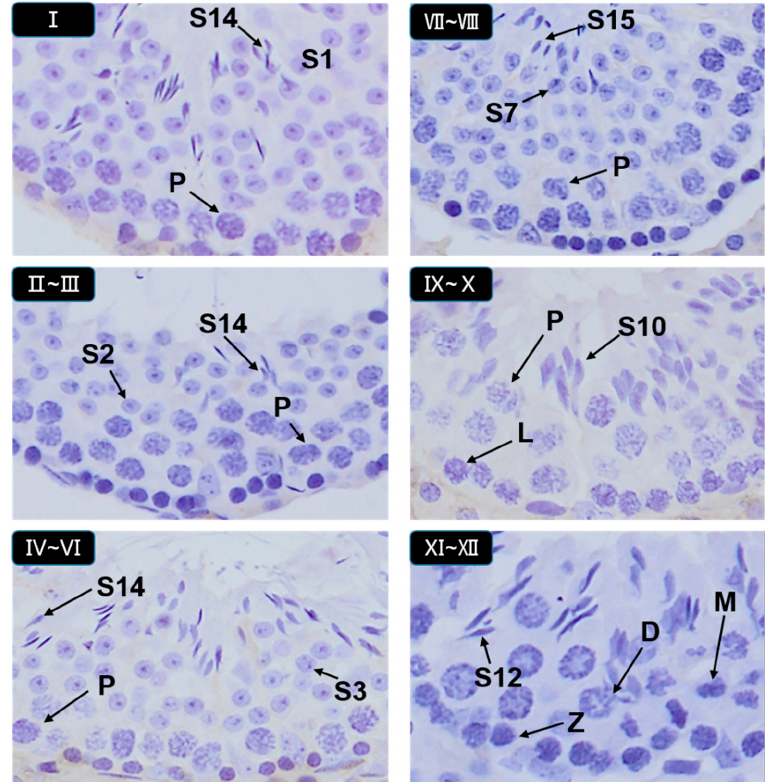
Figure 5. Hematoxylin staining of seminiferous epithelia at stages I–XII. These images were used as